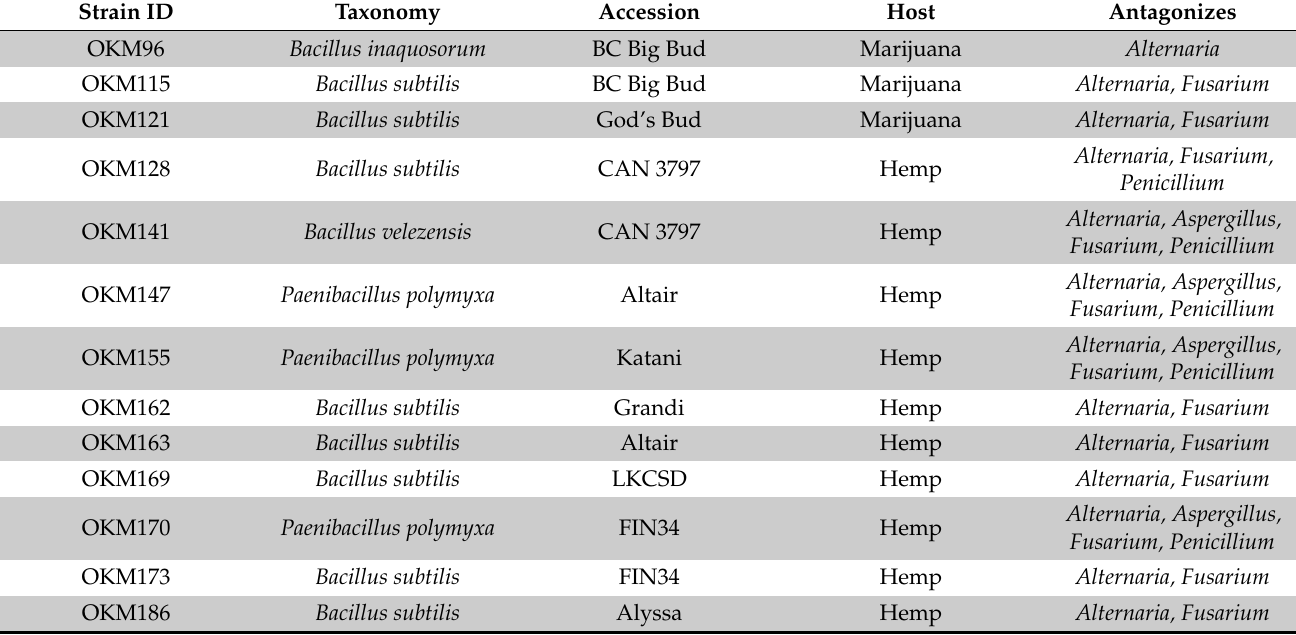
Table 2. Summary of Anti-fungal Activity in Seed-borne Cannabis